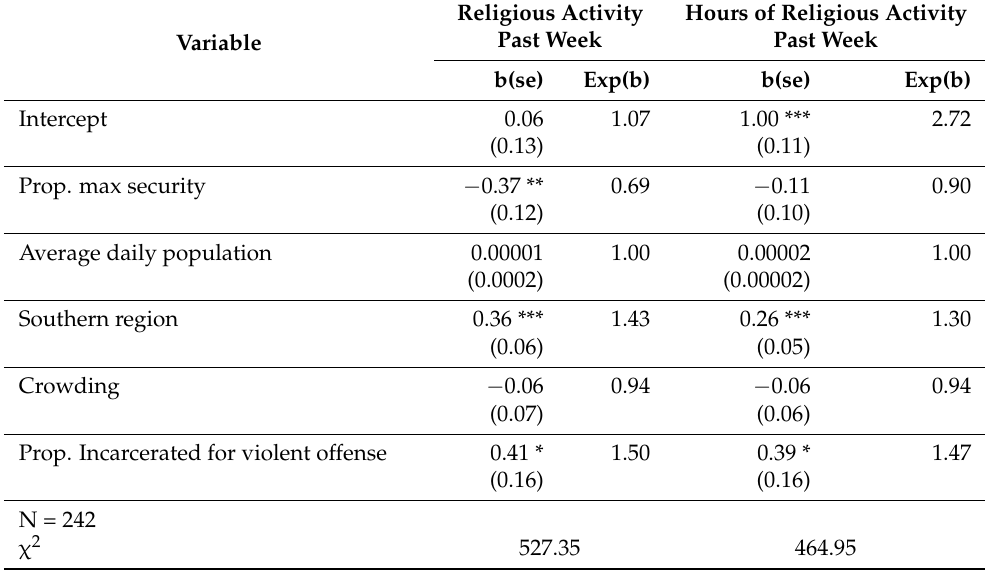
Table 3. Facility level predictors of